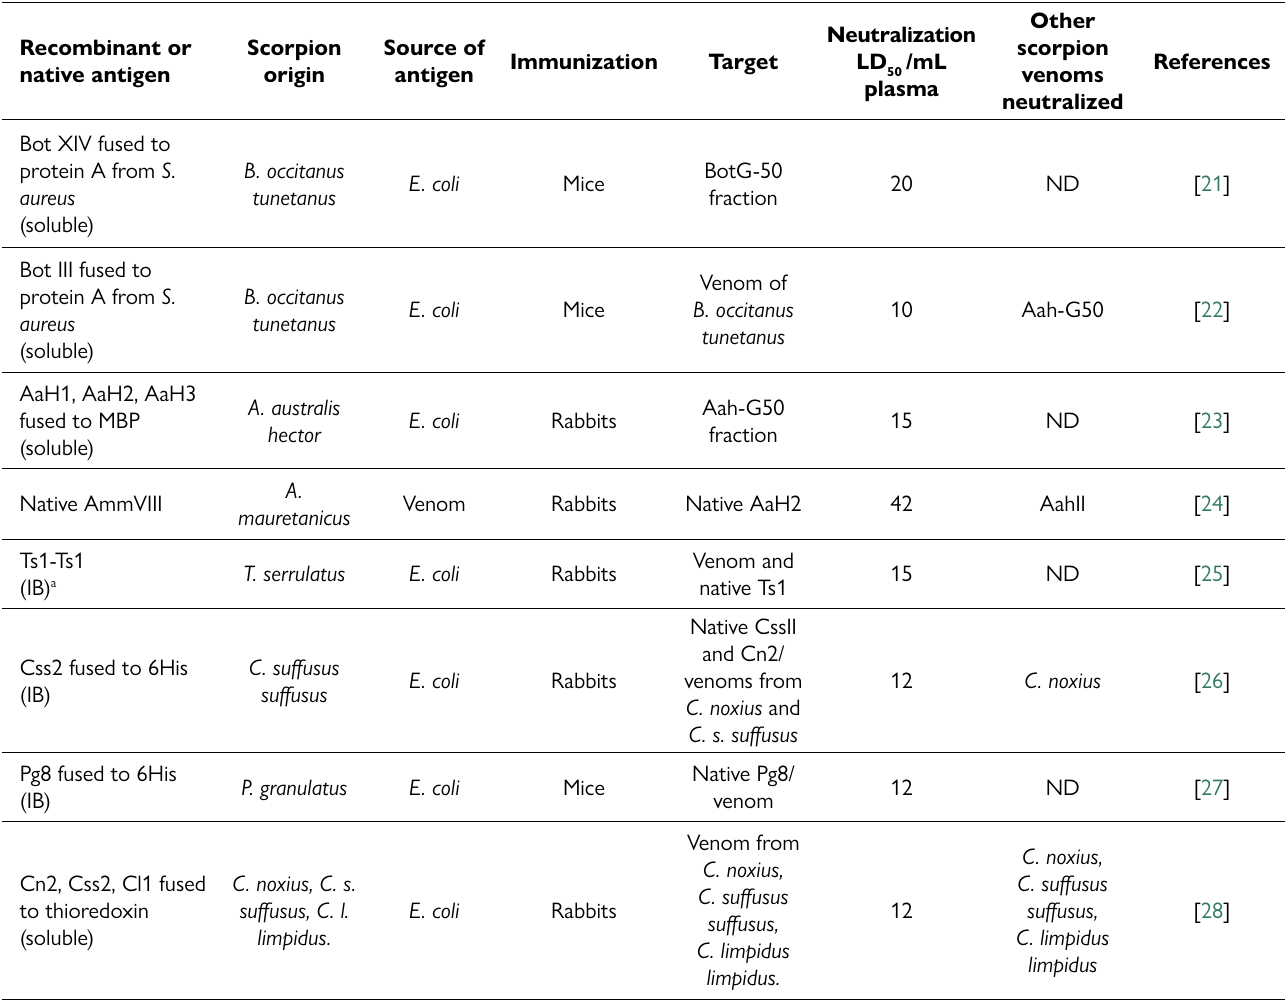
Table 2. Expressed recombinant neurotoxins obtained from scorpion venoms from North Africa and the Middle East.